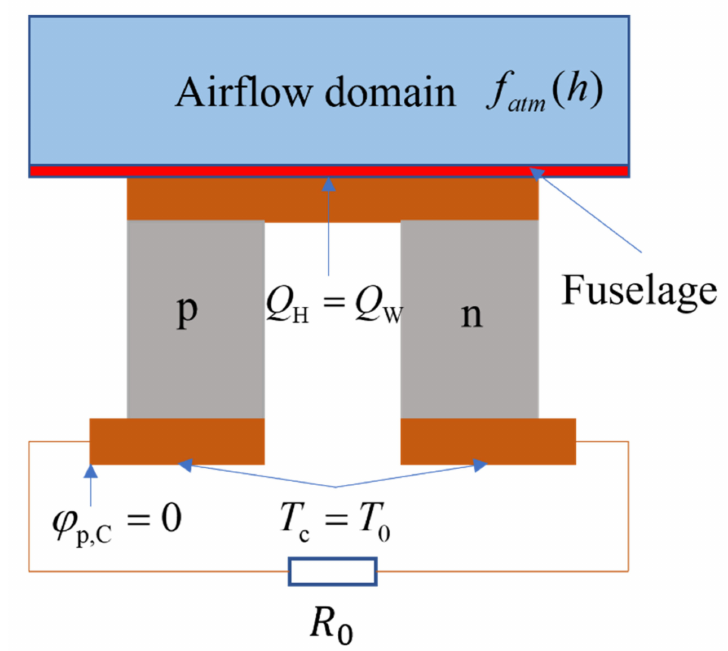
Figure 2. Schematic diagram of the boundary